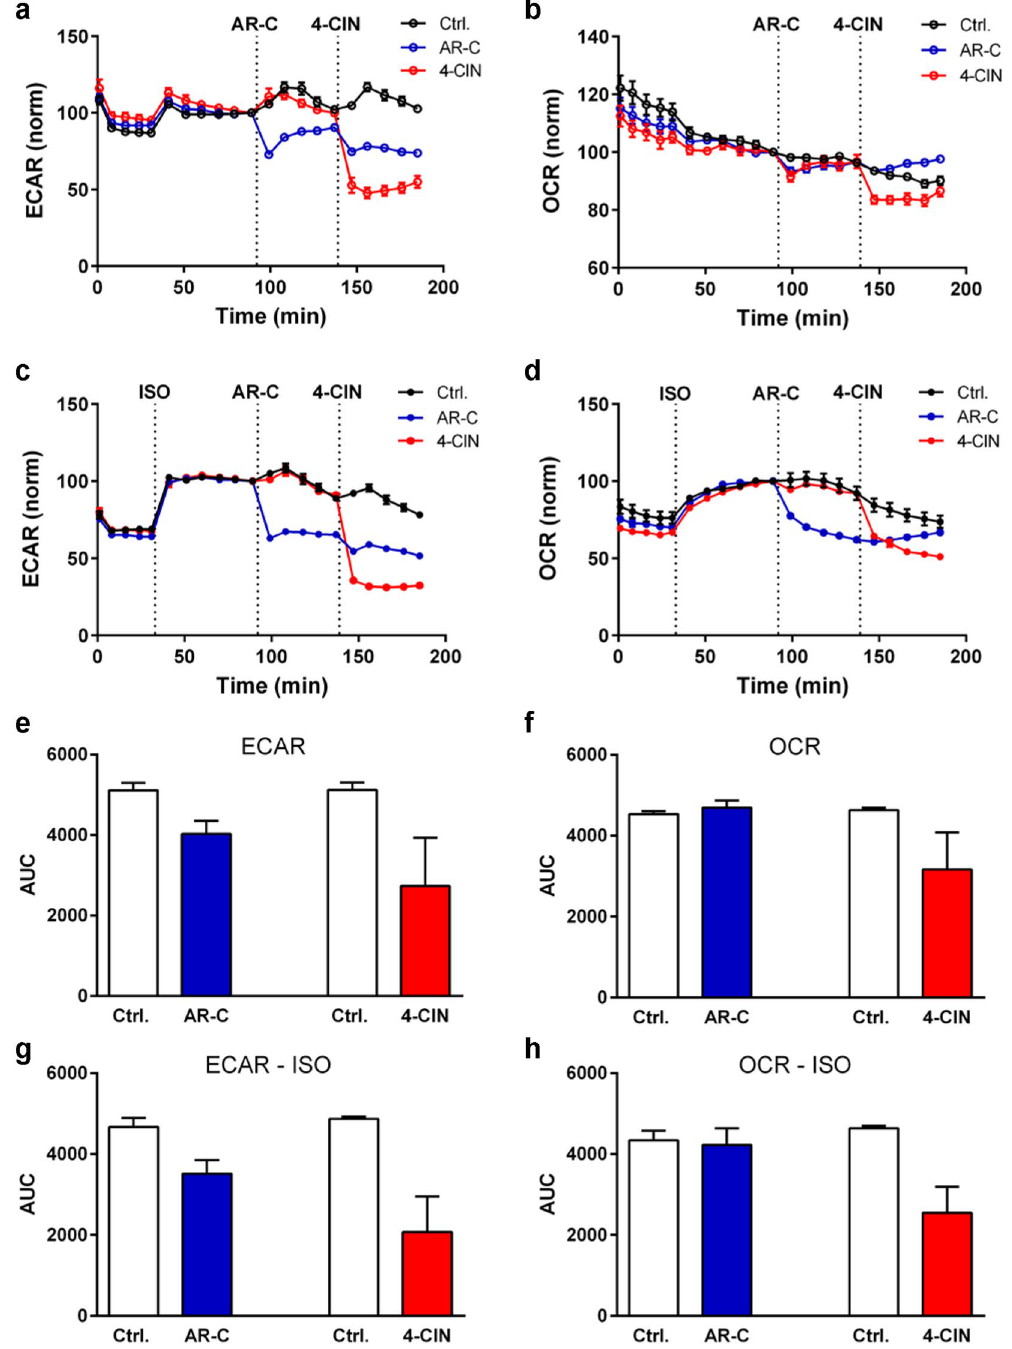
Figure 6. Effect of MCT inhibition on OCR and ECAR of differentiated WT-1 adipocytes under control conditions and after isoproterenol stimulation. On day 6 after induction of differentiation, WT-1 adipocytes were replated into gelatin-coated XF96 Seahorse Analyzer microplates. Analysis of OCR and ECAR was carried out on differentiation day 8 as described in Materials and Methods. Experiments were carried out under control conditions ( a , b , e , f ) or in the presence of isoproterenol (1 µ M, injected as indicated by the dotted line) as a β -adrenergic agonist ( c , d , g , h ). AR-C (10 µ M) and 4-CIN (5 mM) were injected at the times indicated. The data shown in a-d is representative of 3 independent experiments and is given as mean with SD error bars, of 15-16 replicates per condition. e – g . Data summarized over all 3 Seahorse experiments (each performed in 15-16 replicates) are shown as mean with SEM error bars. For each well in each experiment, data from all measurements was normalised to the last point before inhibitor injection and the area under the curve (AUC) was determined for the time-course after that